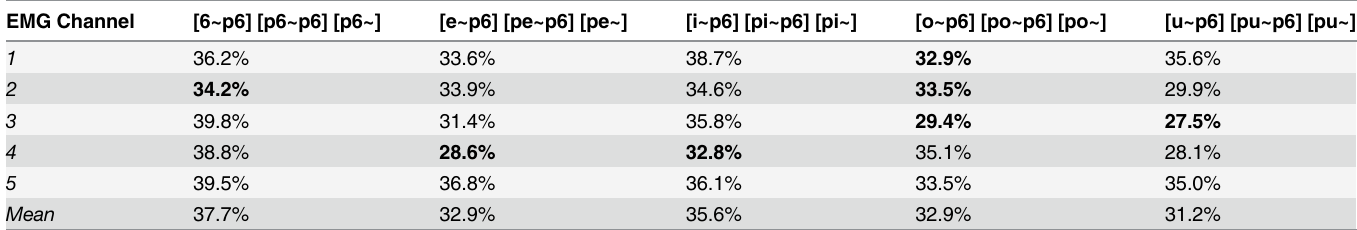
Table 3. Mean error rate grouped by nasal vowel.